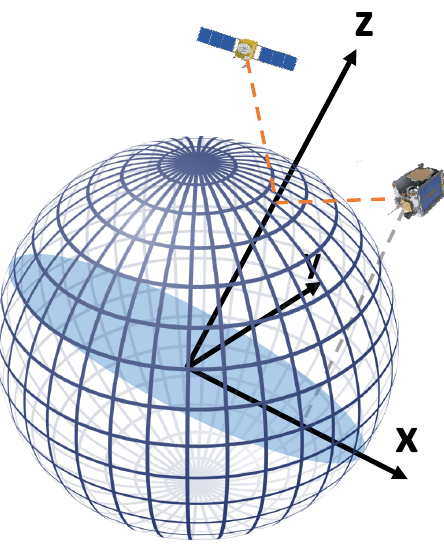
Figure 2. Orientation of the model reference frame used for the numerical